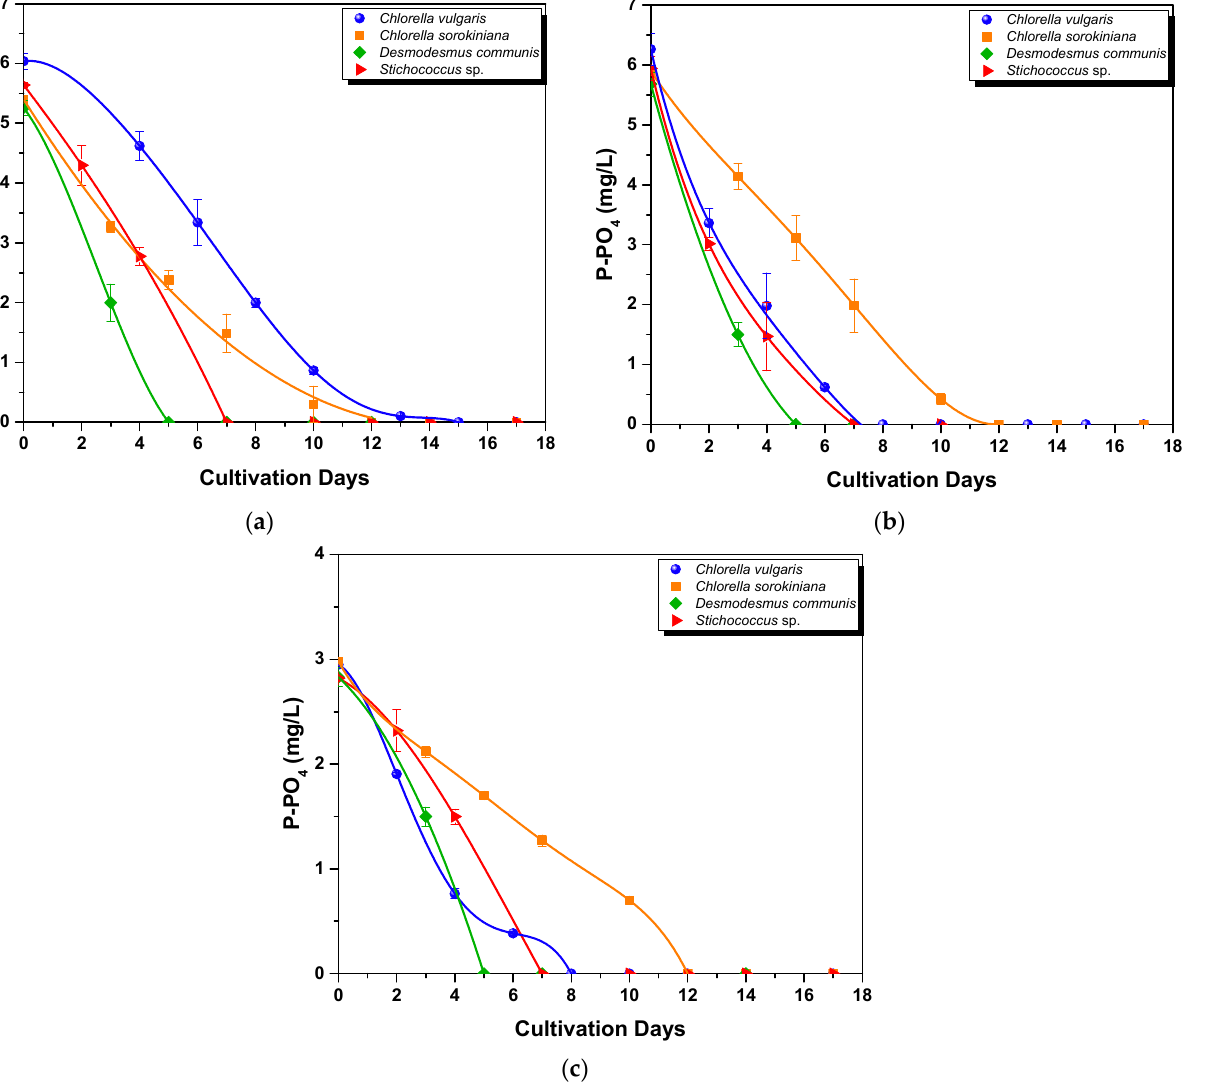
Figure 5. Phosphorus consumption in the three different media by microalgae: ( a ) BG-11 N03 ; ( b ) BG-11 NH4 and ( c ) 3.7% ADE.